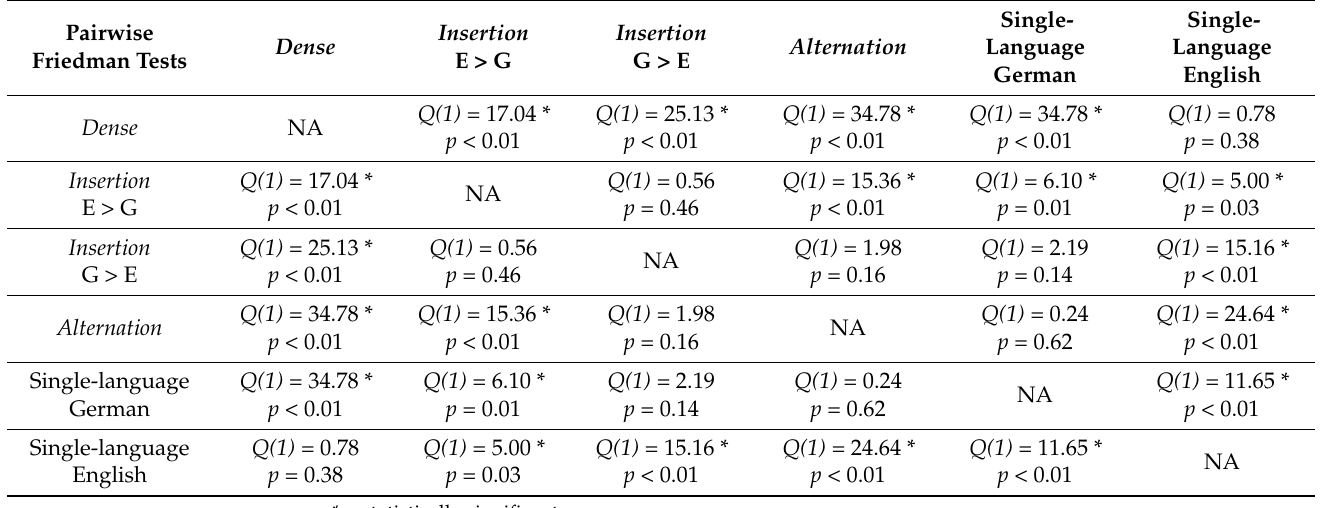
Table 2. Pairwise comparisons sentence repetition task.